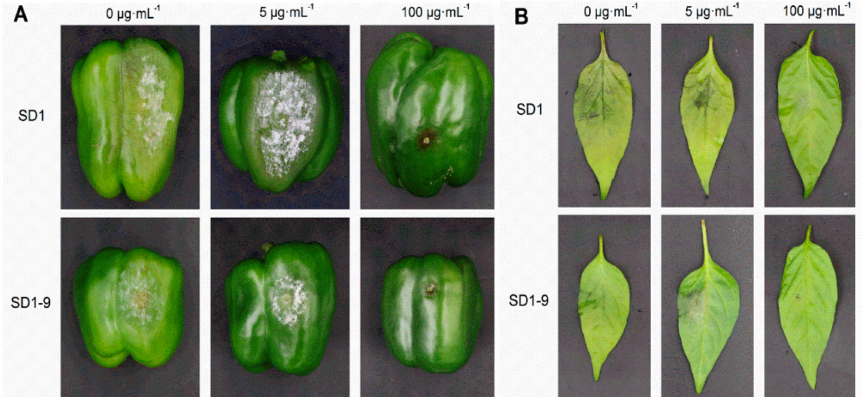
Figure 3. Pathogenicity of P. capsici under di ff erent metalaxyl concentrations. ( A ): Pathogenicity of